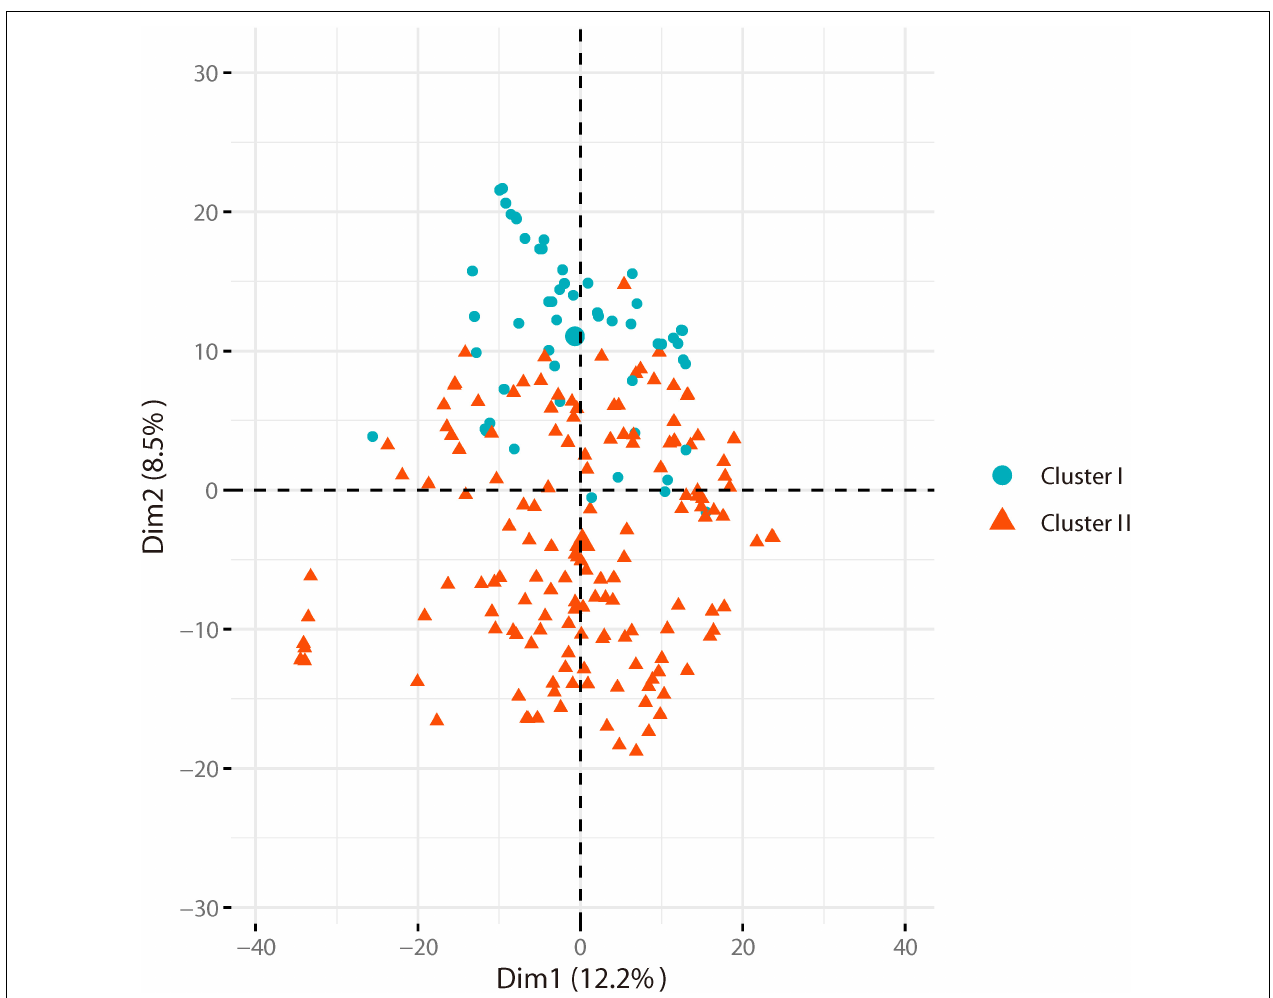
FIGURE 6 | Principal component analysis (PCA) of broccoli accessions. Axes-1 (12.2%) and Axes-2 (8.5%) separate the genotypes into two